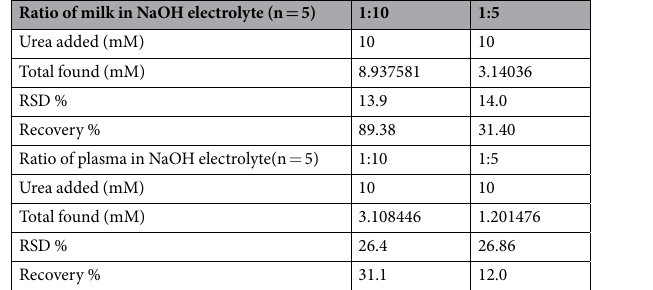
Ratio of milk in NaOH electrolyte (n = 5) 1:10 1:5